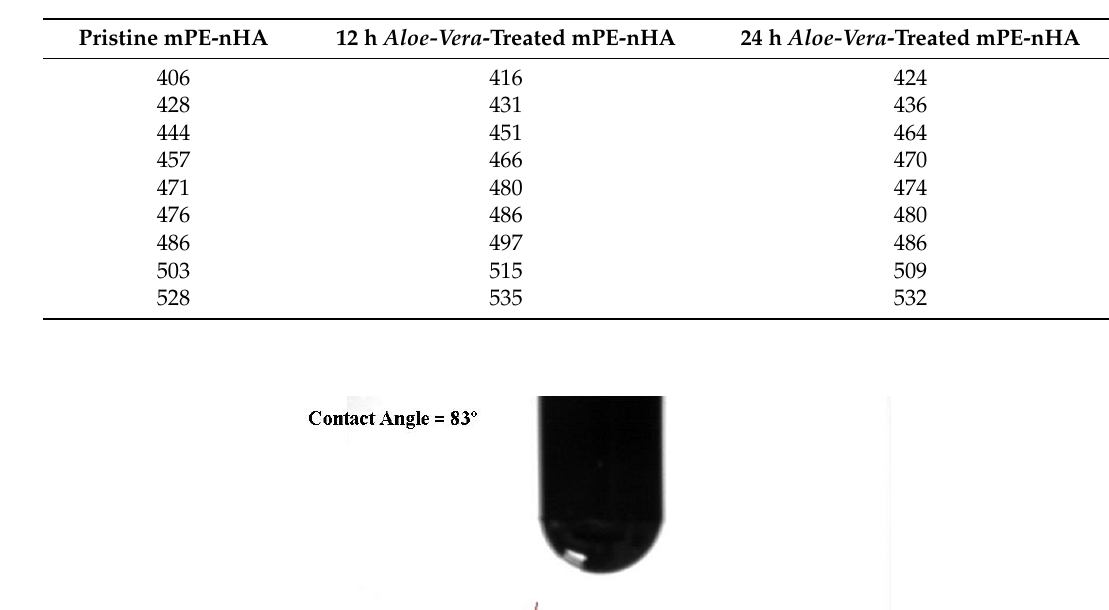
Table 2. Peak shifts observed in Zone A of the recorded FTIR.